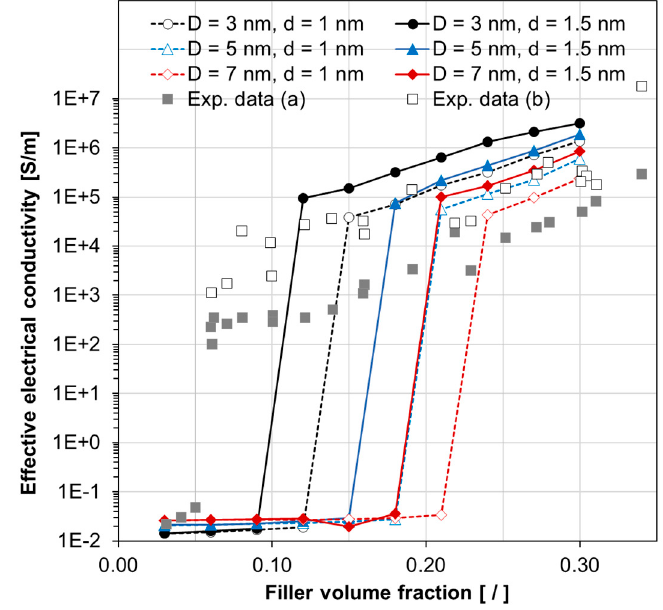
Figure 12. Predicted effective electrical conductivity versus filler volume fraction for silver/epoxy nanocomposites with different particle sizes ( D ) and tunneling distances ( d ). Experimental (Exp.) data (square symbols) are taken from Reference [14], with ( a ) and ( b ) indicating tests before and after thermal treatment, respectively.